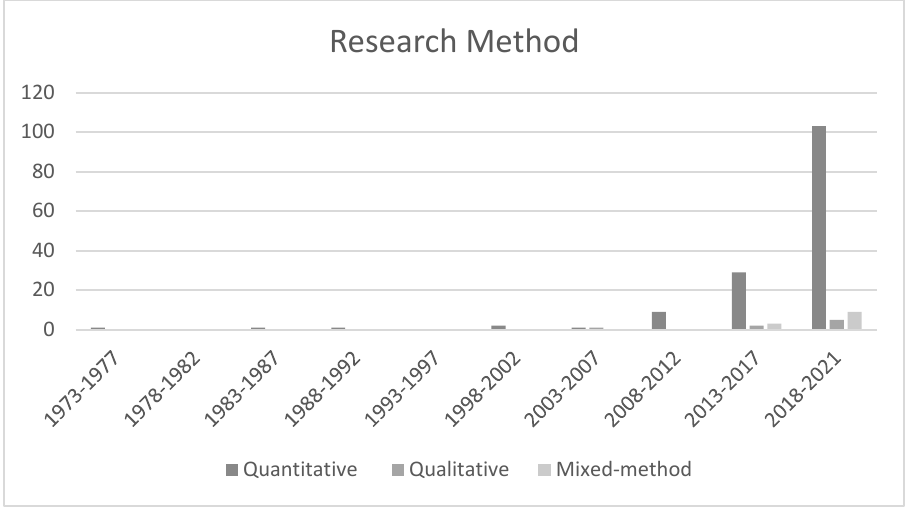
Figure 5. Trend of Research Method by Five-Year Interval during 1973 – 2021 (n = 167).